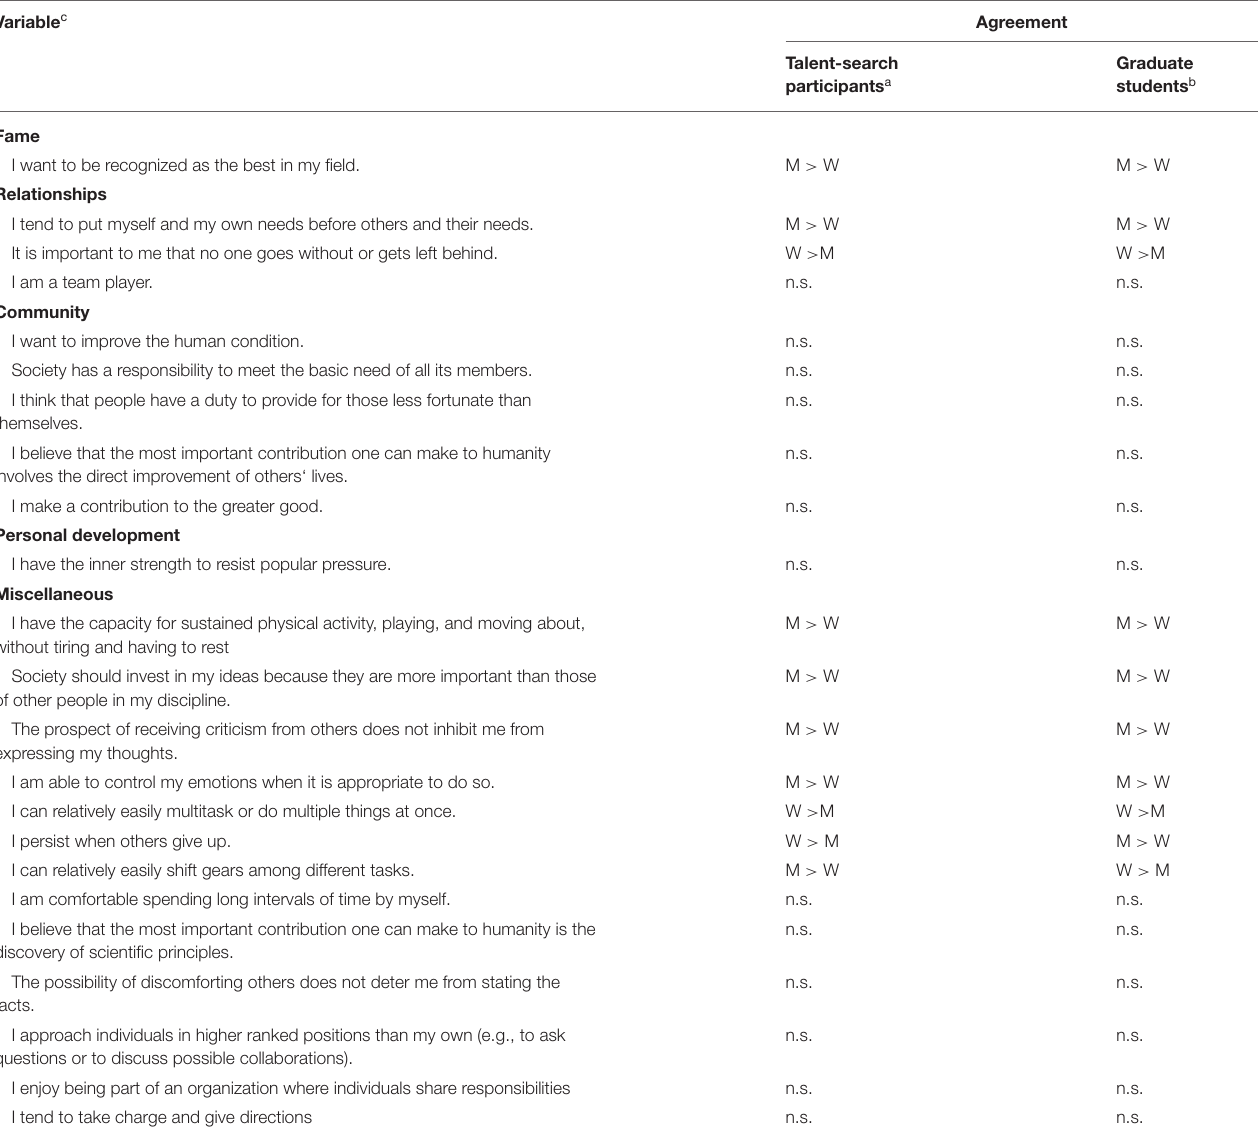
TABLE 5 | Statements on work and personality by gender (Ferriman et al., 2009). Variable